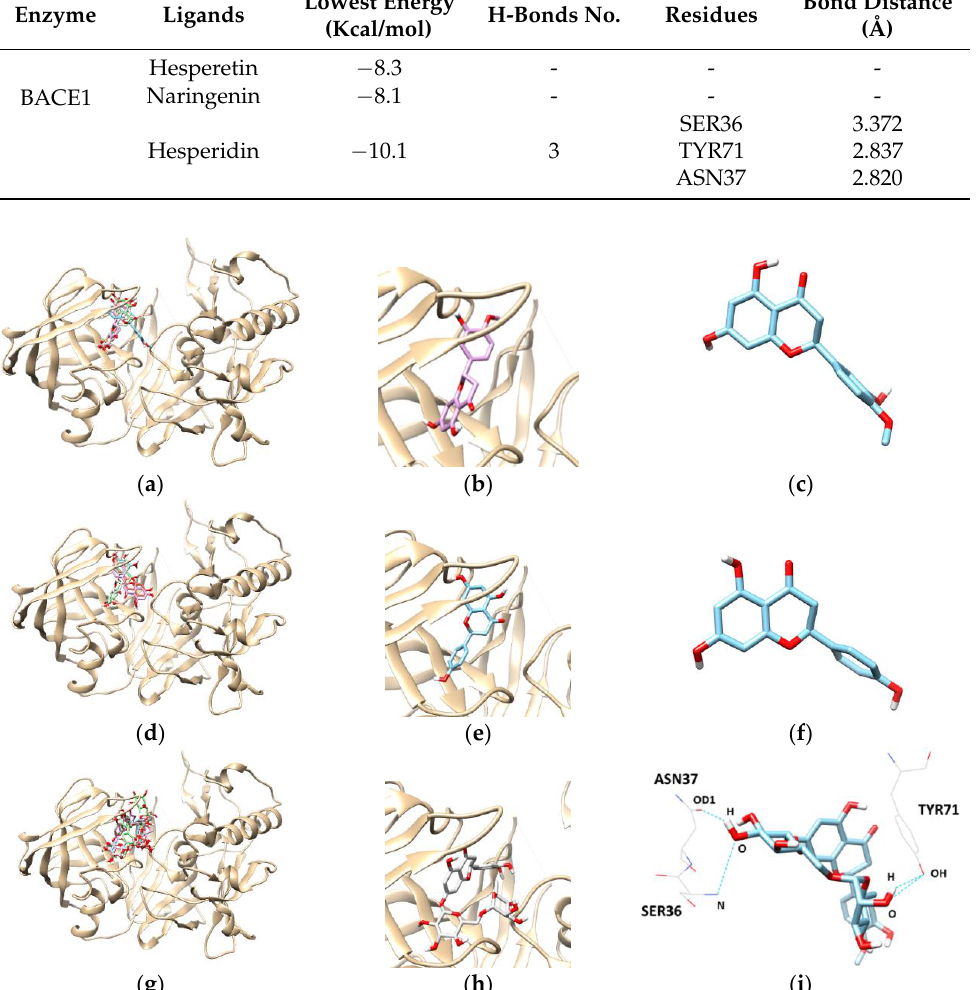
Figure 4. The best docked poses between BACE1 and hesperetin ( a ); naringenin ( d ); and hesperidin ( g ). View of the binding site magnified from hesperetin ( b ); naringenin ( e ); and hesperidin ( h ). Hydrogen interaction diagram of hesperetin ( c ); naringenin ( f ); and hesperidin ( i ). The blue dotted lines indicate hydrogen bonds between flavanones and